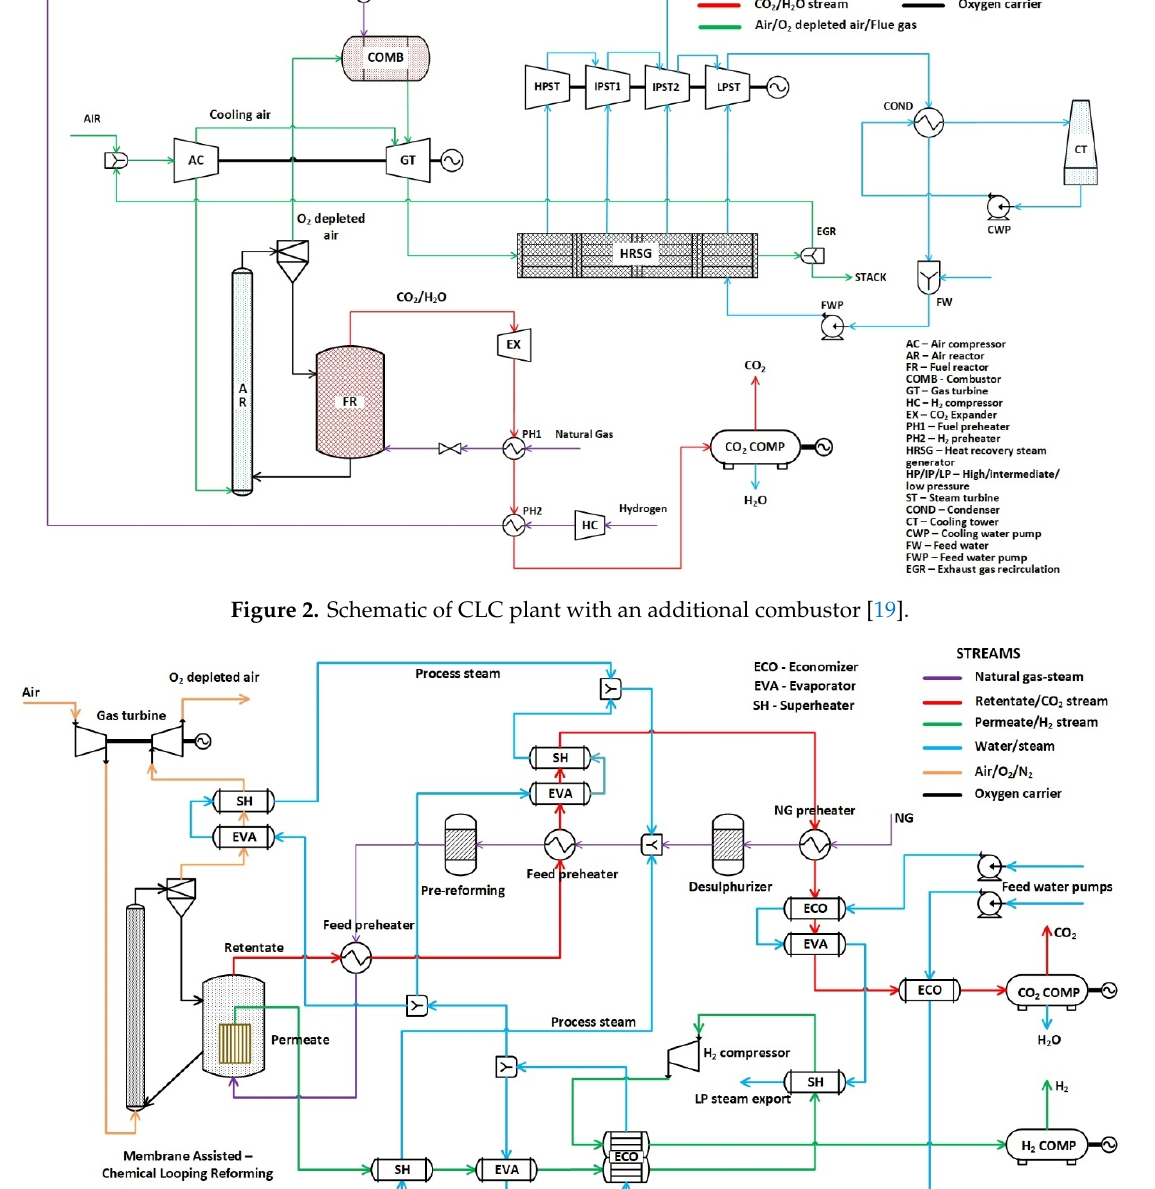
Table 2. Summary of the CLC and MA-CLC integrations investigated in this